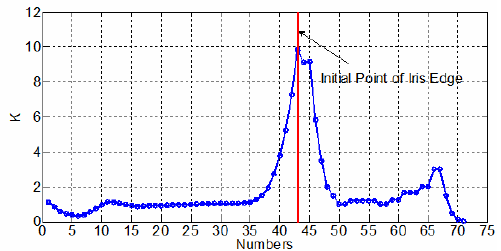
Figure 9: The ratio of line integral along the initial search line.